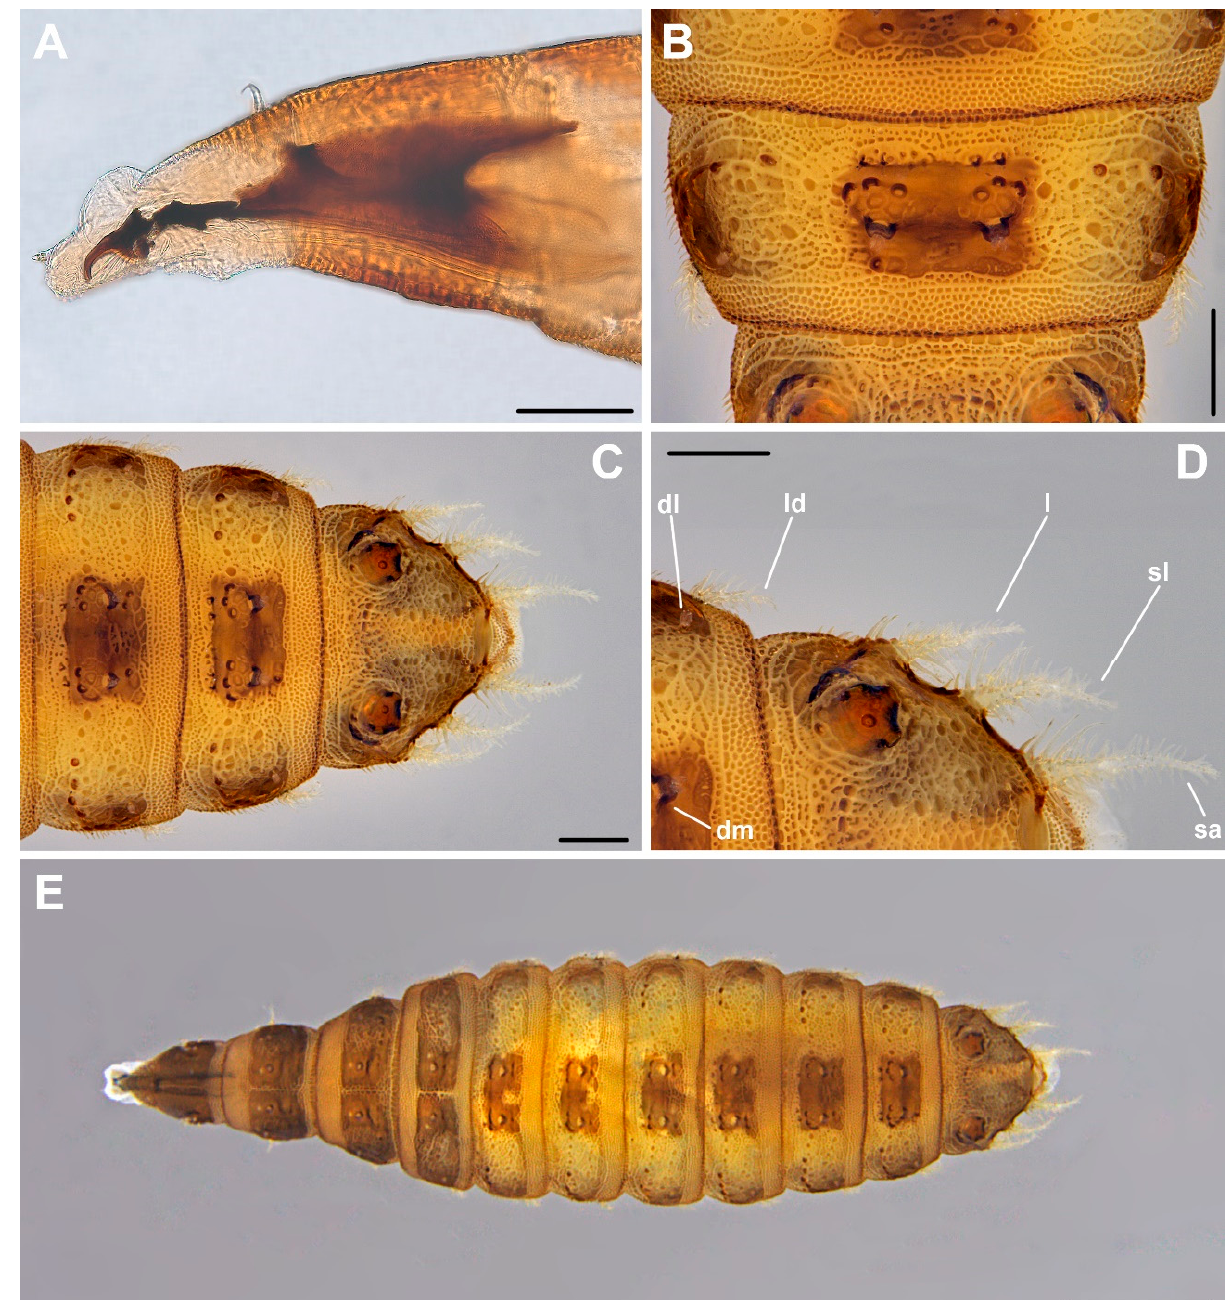
Figure 3. Third instar larva of Fannia nigra : ( A ) anterior body end with cephaloskeleton; ( B ) seventh abdominal segment, dorsal view; ( C ) posterior body end, dorsal view; ( D ) seventh abdominal segment and anal division, dorsal view; ( E ) larva in dorsal view. Scale bar 100 µm ( A ), 250 µm ( B – D ) and 1 mm ( E ). Abbreviations: dl, dorsolateral process; dm, dorsomedian process; l, lateral process; ld, laterodorsal process; sa, subapical process; sl, sublateral process.